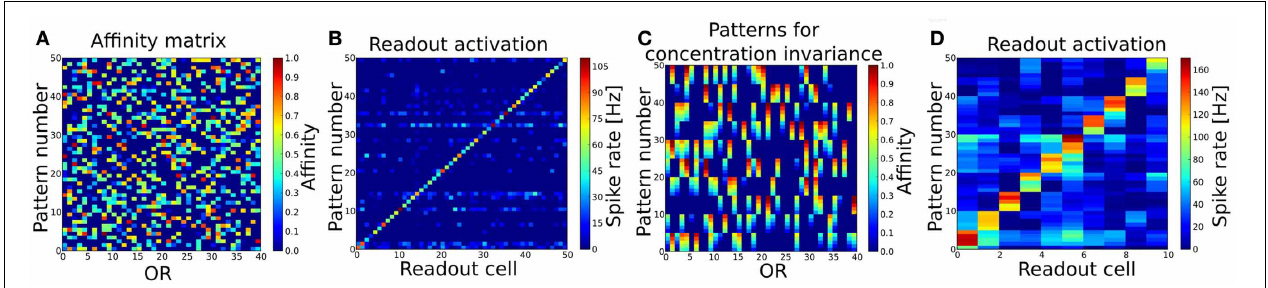
FIGURE 4 | (A) Patterns to train and test the basic pattern recognition capabilitiesofthesystem(Task1).40ORsareactivatedin50differentpatterns. Per pattern 30–50% of all ORs are activated. (B) Readout activity for pattern recognition test. As input served the 50 patterns shown in (A) . (C) Patterns to